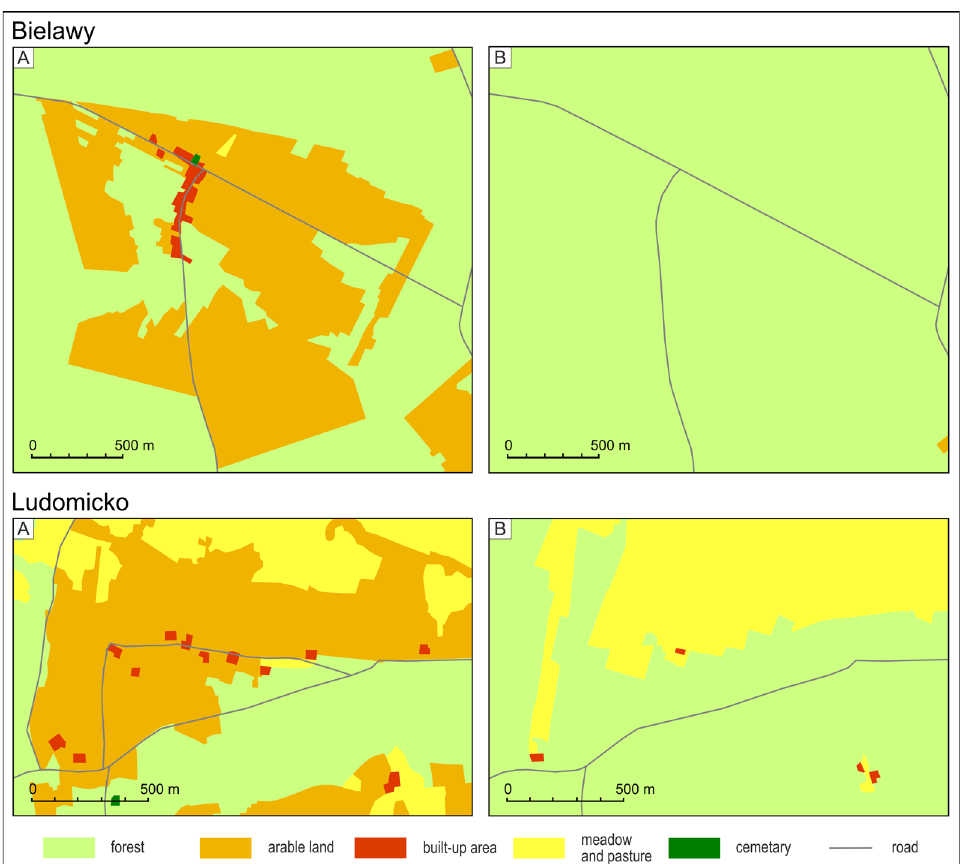
Fig. 6. Changes in land use structure in the villages of Bielawy and Ludomicko: A – Messtischblatter